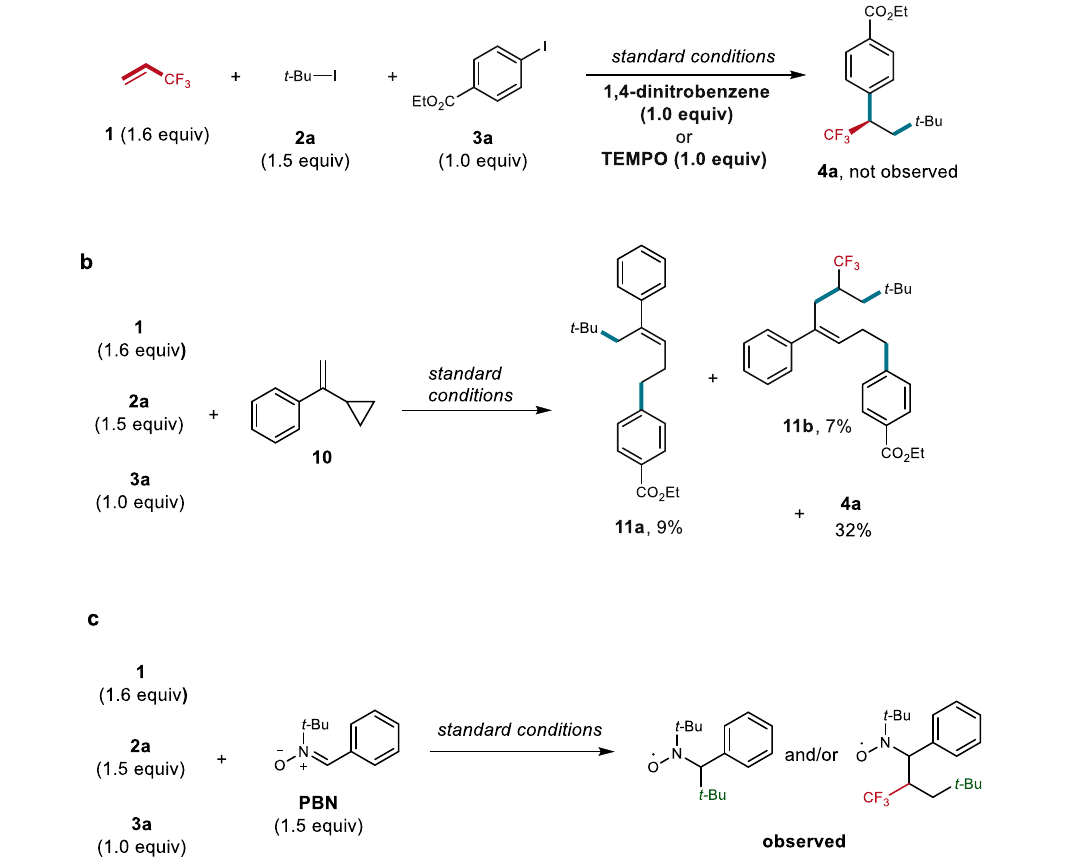
Fig. 4 | Radical trapping experiments. a Radical inhibition experiments. b Radical clock experiment. c EPR